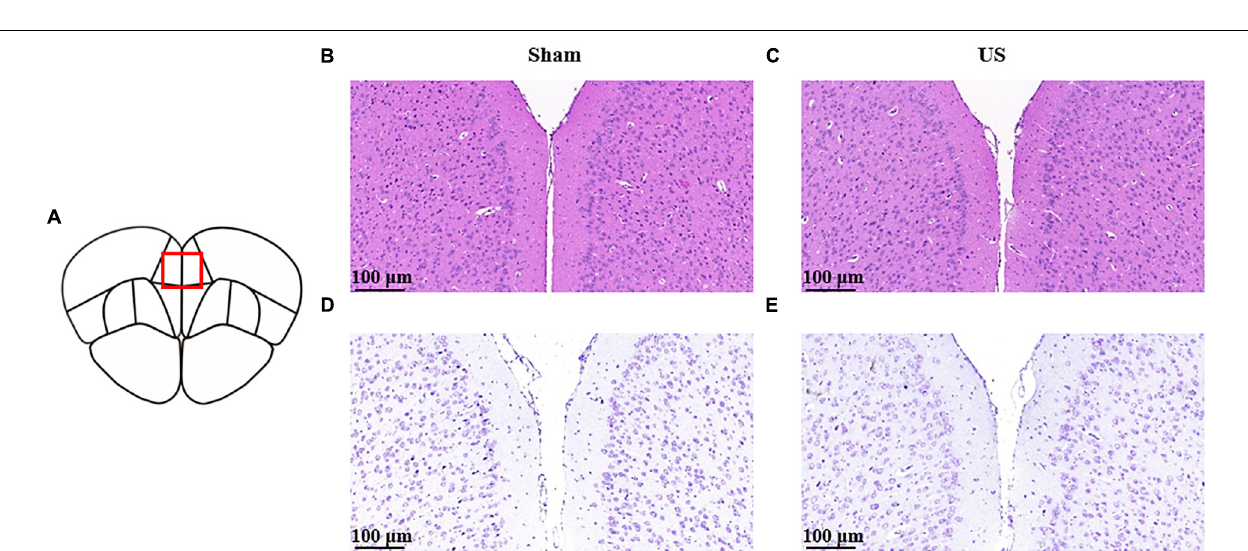
Frontiers in Psychiatry |